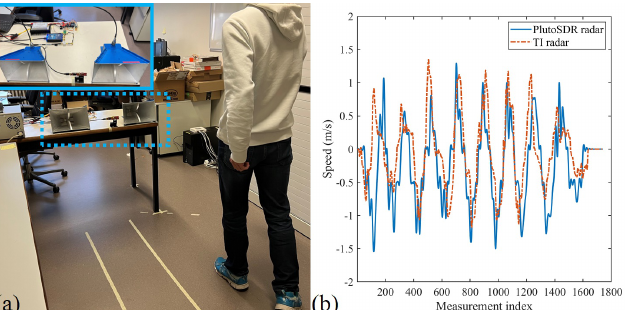
Figure 5. ( a ) Experimental setup for CW speed test. ( b ) Speed measurement results of PlutoSDR radar and TI radar.